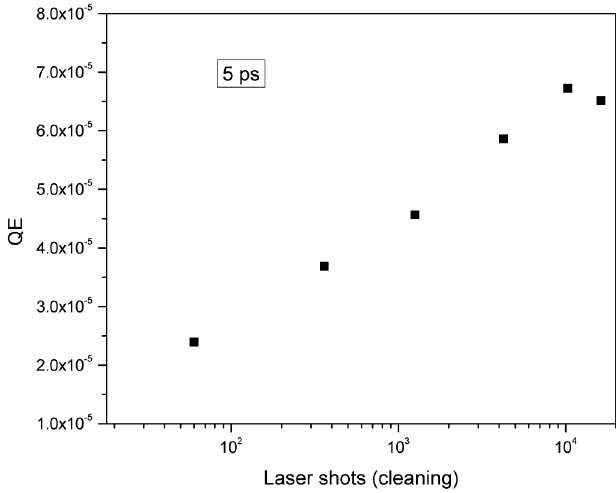
FIG. 7. QE of the film deposited with 5 ps pulse duration and 0 : 12 J = cm 2 , as a function of the number of cleaning pulses with an energy density of 0 : 04 J = cm 2 .